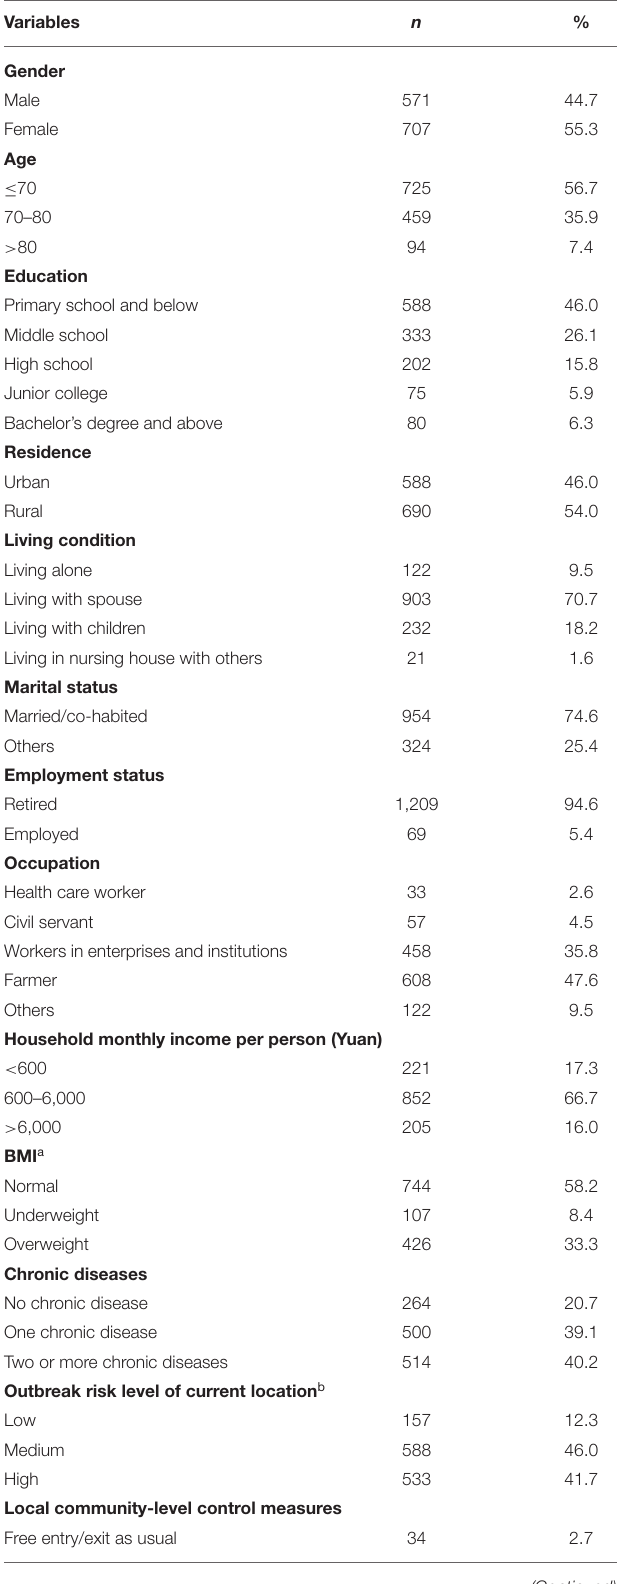
TABLE 1 | Study sample characteristics ( N =